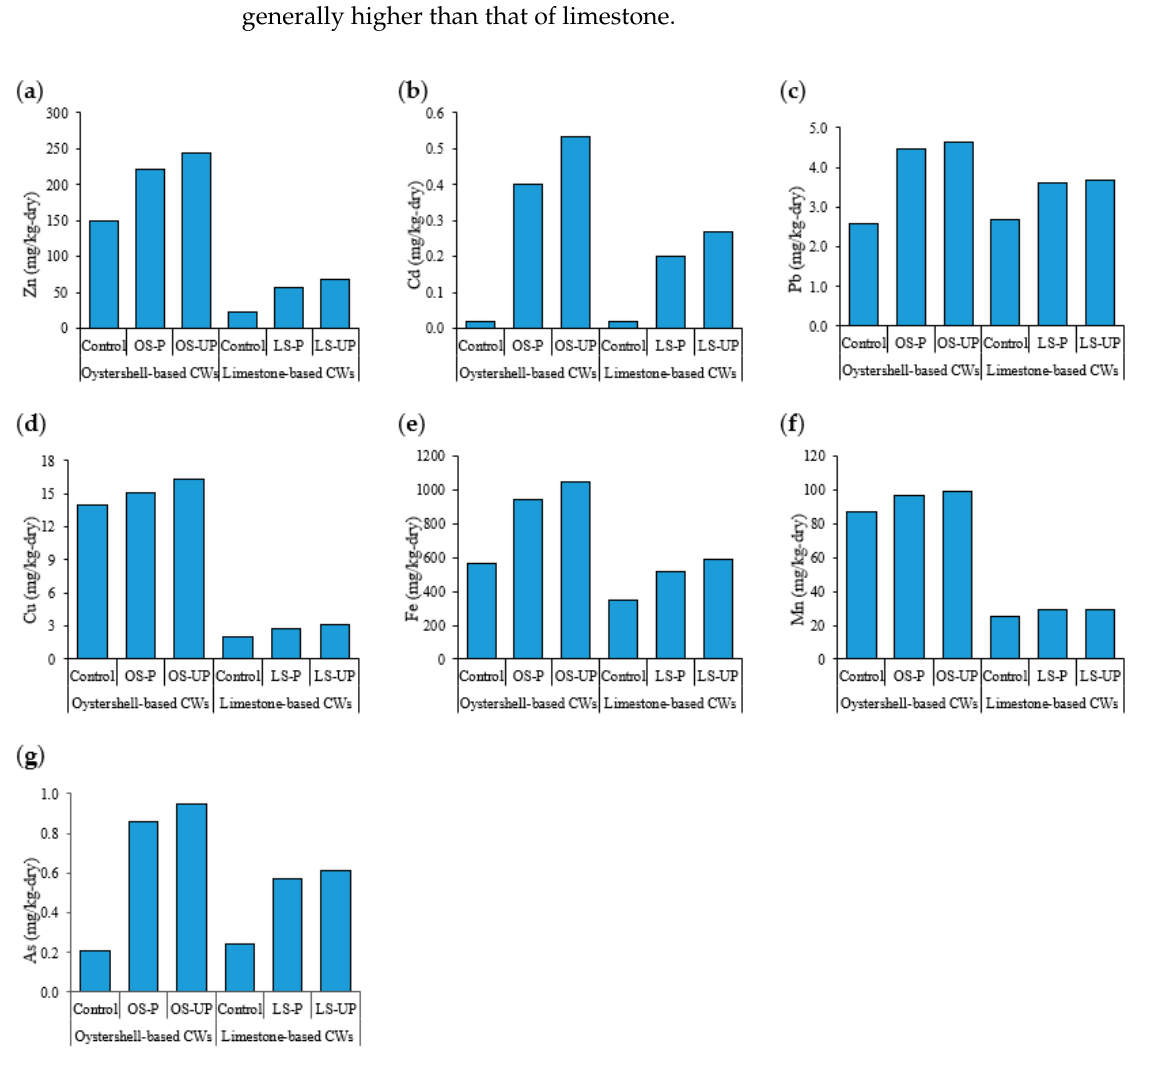
Figure 4. Heavy metal contents in oyster shells and limestone in CWs before and after 7-month AMD treatment: Zn ( a ), Cd ( b ), Pb ( c ), Cu ( d ), Fe ( e ), Mn ( f ), and As ( g